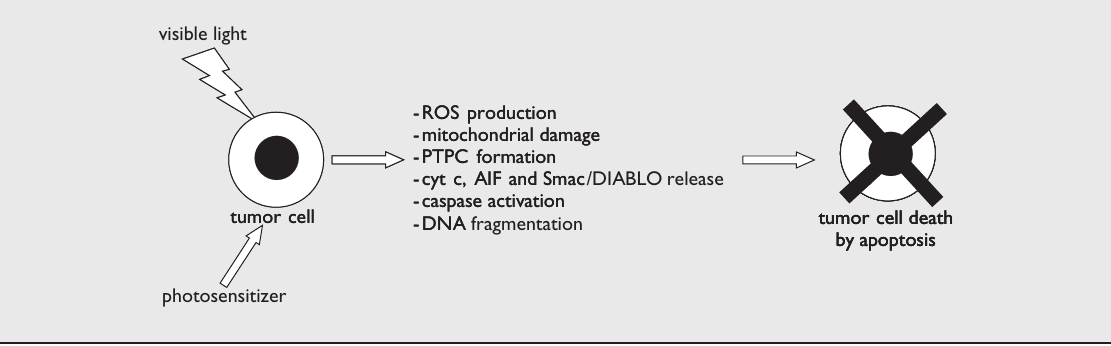
Figure 5 – Apoptosis in photodynamic therapy with participation of